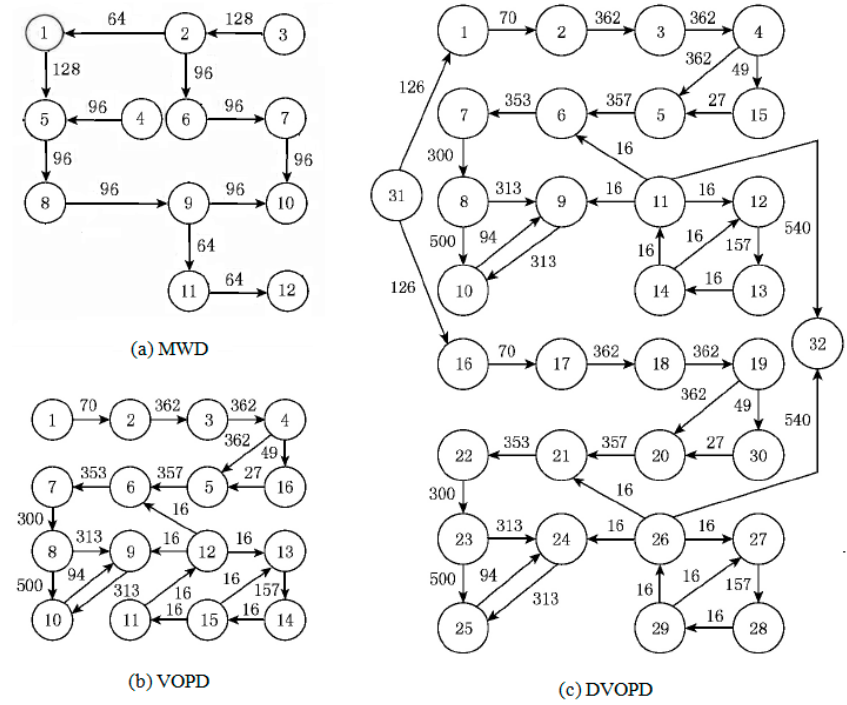
Figure 9. Classic task graph.